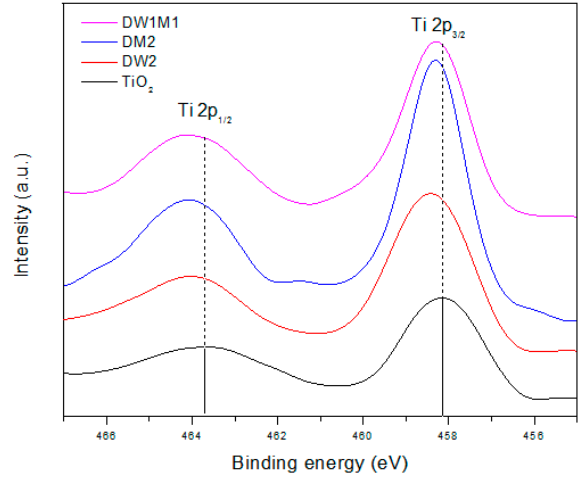
Figure 8. XPS spectra of Ti 2p for undoped, doped, and co-doped TiO 2 samples with W and Mo.